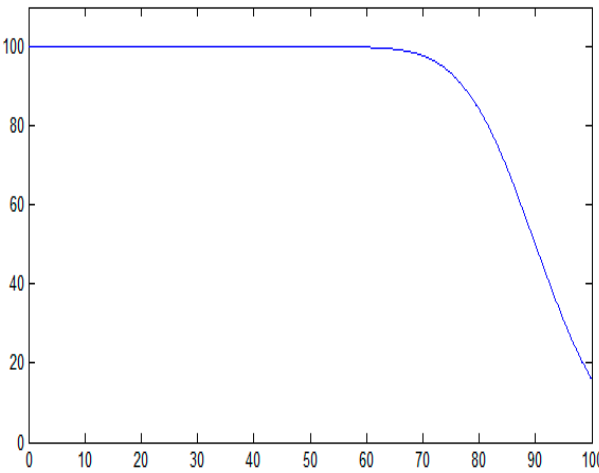
Figure 11. Scaled reliability function of normal distribution for KZM100-MOD-Y.